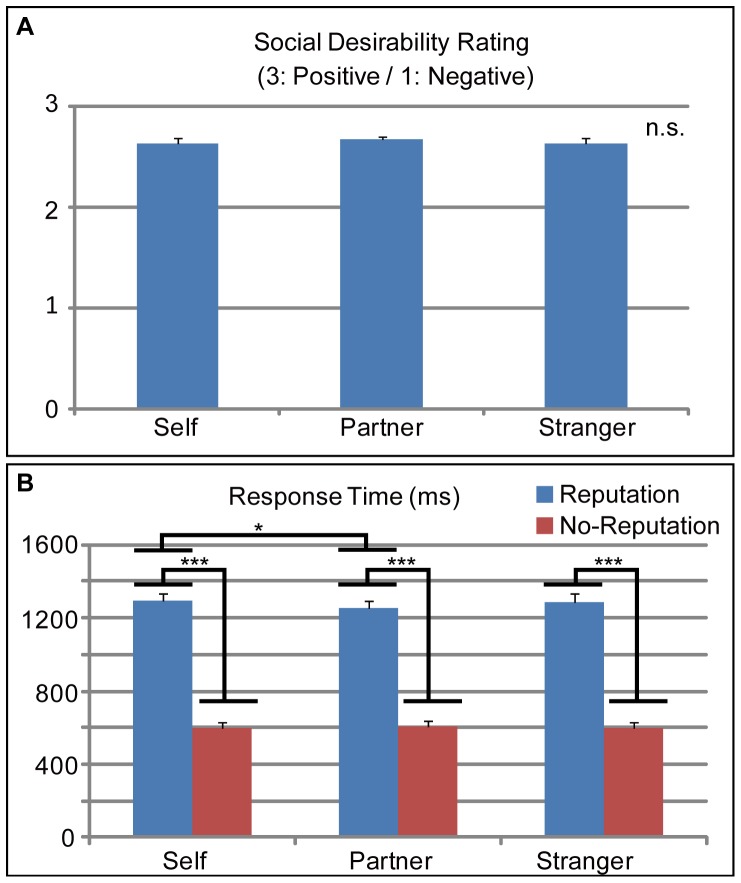
Social desirability judgment data.(A) Average (SEM) values of the social desirability ratings of the reputation words during three conditions. None of the pairs showed significant differences in ratings. (B) Average (SEM) response times for the social desirability ratings (blue bars) and button presses (red bars) during the three conditions. A two-way (reputation [reputation/no-reputation]×target [self/partner/stranger]) repeated measures analysis of variance (rmANOVA) showed significant interaction effects (p<0.05) and a significant main effect of reputation. Post-hoc analysis revealed that each of the three target conditions showed significant differences between the reputation and no-reputation conditions.